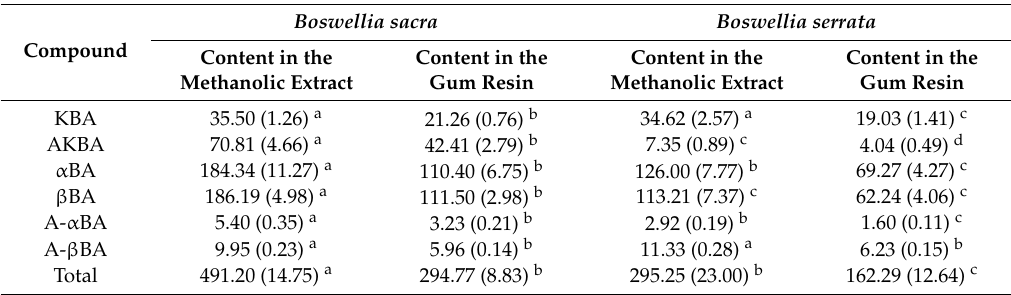
Table 2. Quantitative determination of boswellic acids in Boswellia sacra and Boswellia serrata by High Performance Liquid Chromatography-Diode Array Detector coupled to ElectroSpray Ionization and tandem Mass Spectrometry (HPLC-DAD-ESI-MS/MS), by using calibration curves from pure standards. Data are expressed as g · kg − 1 gum resin dry weight. (Standard deviation), in the same row, different letters indicate significant ( p < 0.05) differences.